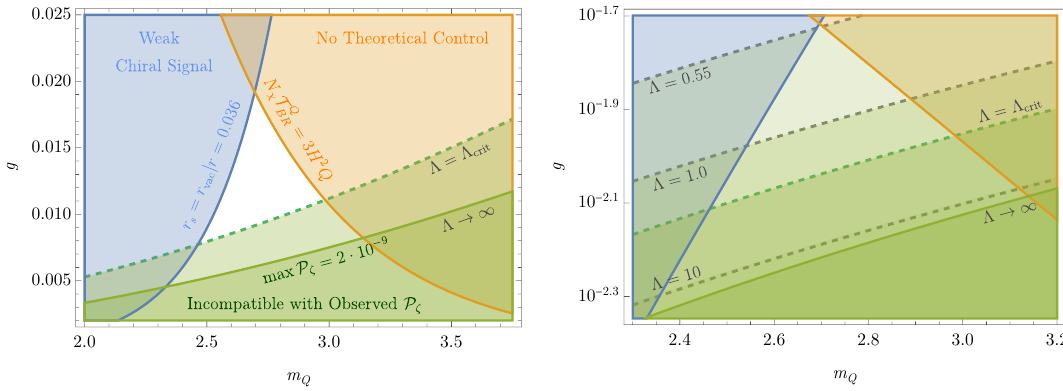
Figure 1 . The various constraints from the low energy EFT are superposed to determine √ the allowed m Q − g parameter space. (CON.4), 2 < m Q , is satisfied everywhere on both panels. The blue shaded region doesn’t provide a strong chiral gravitational signal and is in violation of (CON. 2 ∗ ). The orange shaded region experiences too much contamination from the backreaction (CON.5). The green shaded region with a solid border is incompatible with (CON. 3 ∗ ) and only predicts scalar power spectrum values that are smaller than P obs = 2 . 1 · 10 − 9 . Its solid ζ green border corresponds to Λ → ∞ . (Left Panel) Only a small white region doesn’t violate any of the constraints. As we lower Λ the solid green border moves higher and reduces the available parameter space (see (3.6)). The green shaded region with a dashed border breaks (CON.3) for √ values of Λ ≥ Λ crit ∼ 2 (see (4.6)). (Right Panel) The viable region for m Q − g values (see left panel) superposed with dashed gray Λ min = const. contours that saturate (4.8). For any pair ( m Q , g ) , there is a limit on how low Λ can go and still accommodate the correct value for P ζ . No choice of ( m Q , g ) allows for Λ . 0 . 55 , whereas Λ → ∞ represents the irreducible, conservative, ruled-out region of parameter space where no value of Λ is